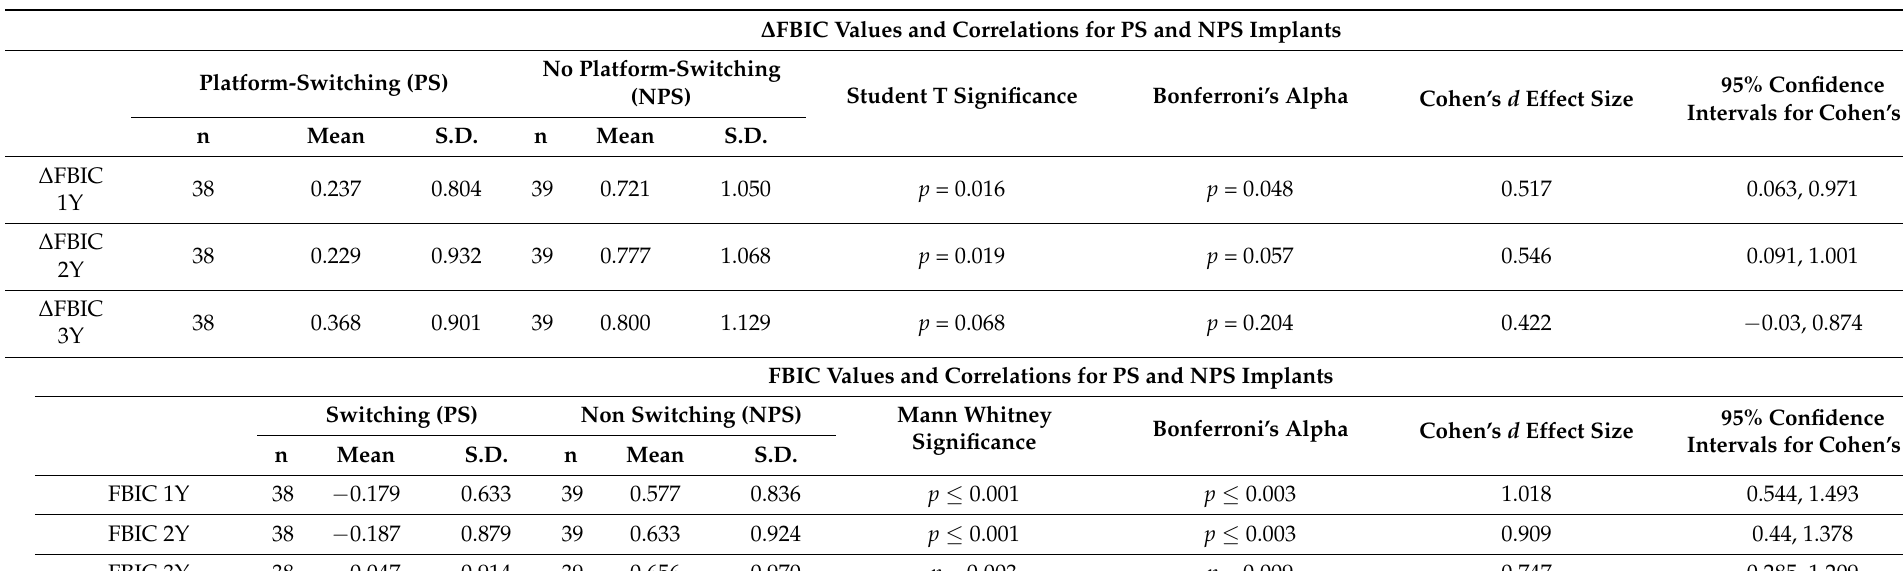
Table 3. FBIC and ∆ FBIC values during follow-up period. Amount of bone loss (mm) was higher for NPS implants compared to PS implants during observation period. ∆ FBIC Values and Correlations for PS and NPS Implants